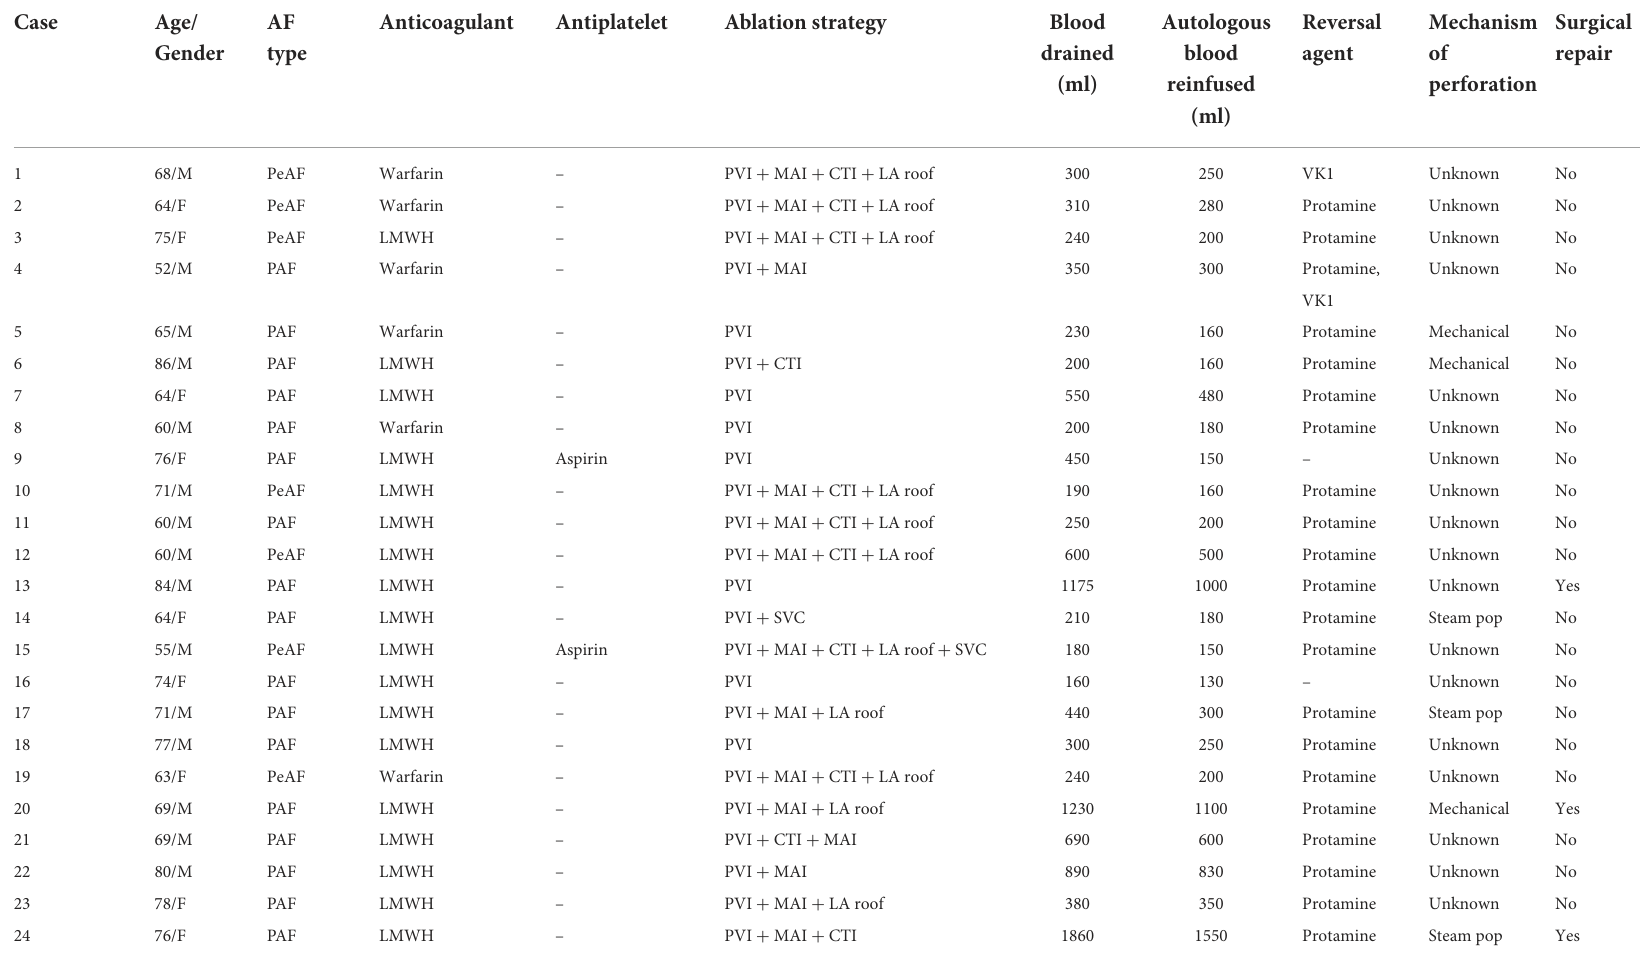
TABLE 2 Clinical characteristics of 46 cases of direct